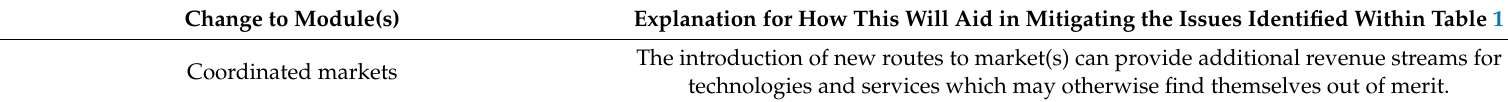
Table 5. How the proposed design can aid in mitigating the issues identified within Table 1. Authors’